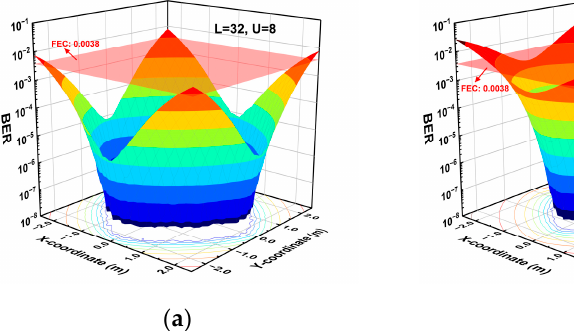
Figure 4. Surface diagram of BER estimated at all testing points when the user number is ( a ) 8 users, ( b ) 12 users, and ( c ) 16 users.